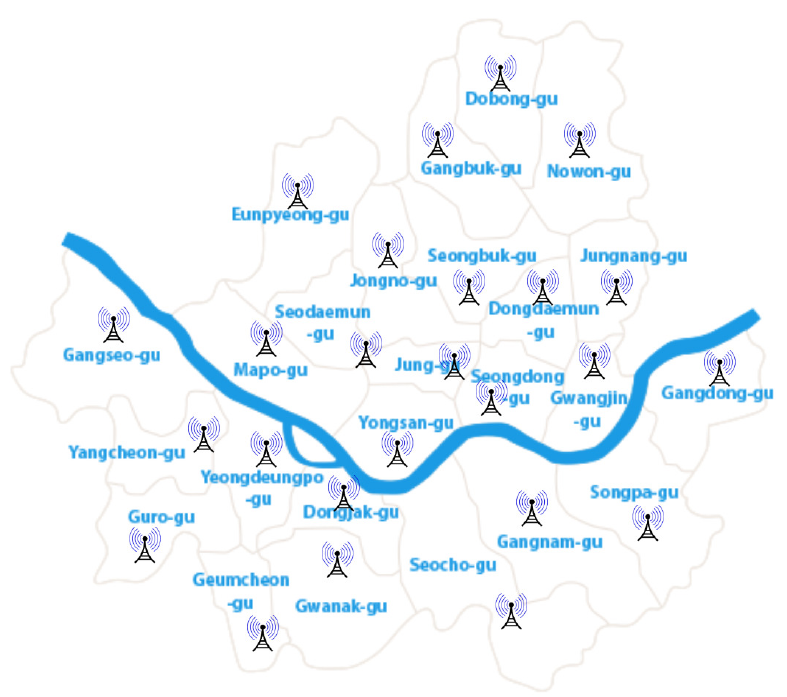
Figure 2. Deployment of IoT monitoring stations in